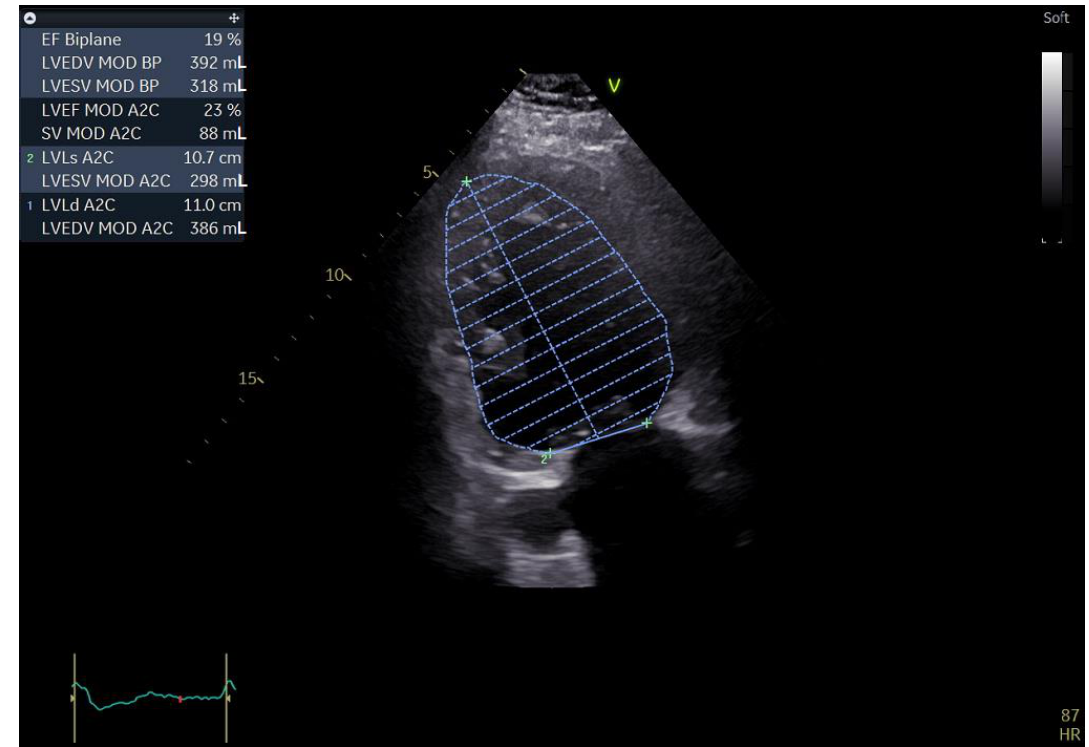
Figure 1. Two-dimensional echocardiography: apical two chamber view showing a severely dilated left ventricle along with a severely impaired LVEF; the top left of the picture showing the aforementioned measurements (biplane results).